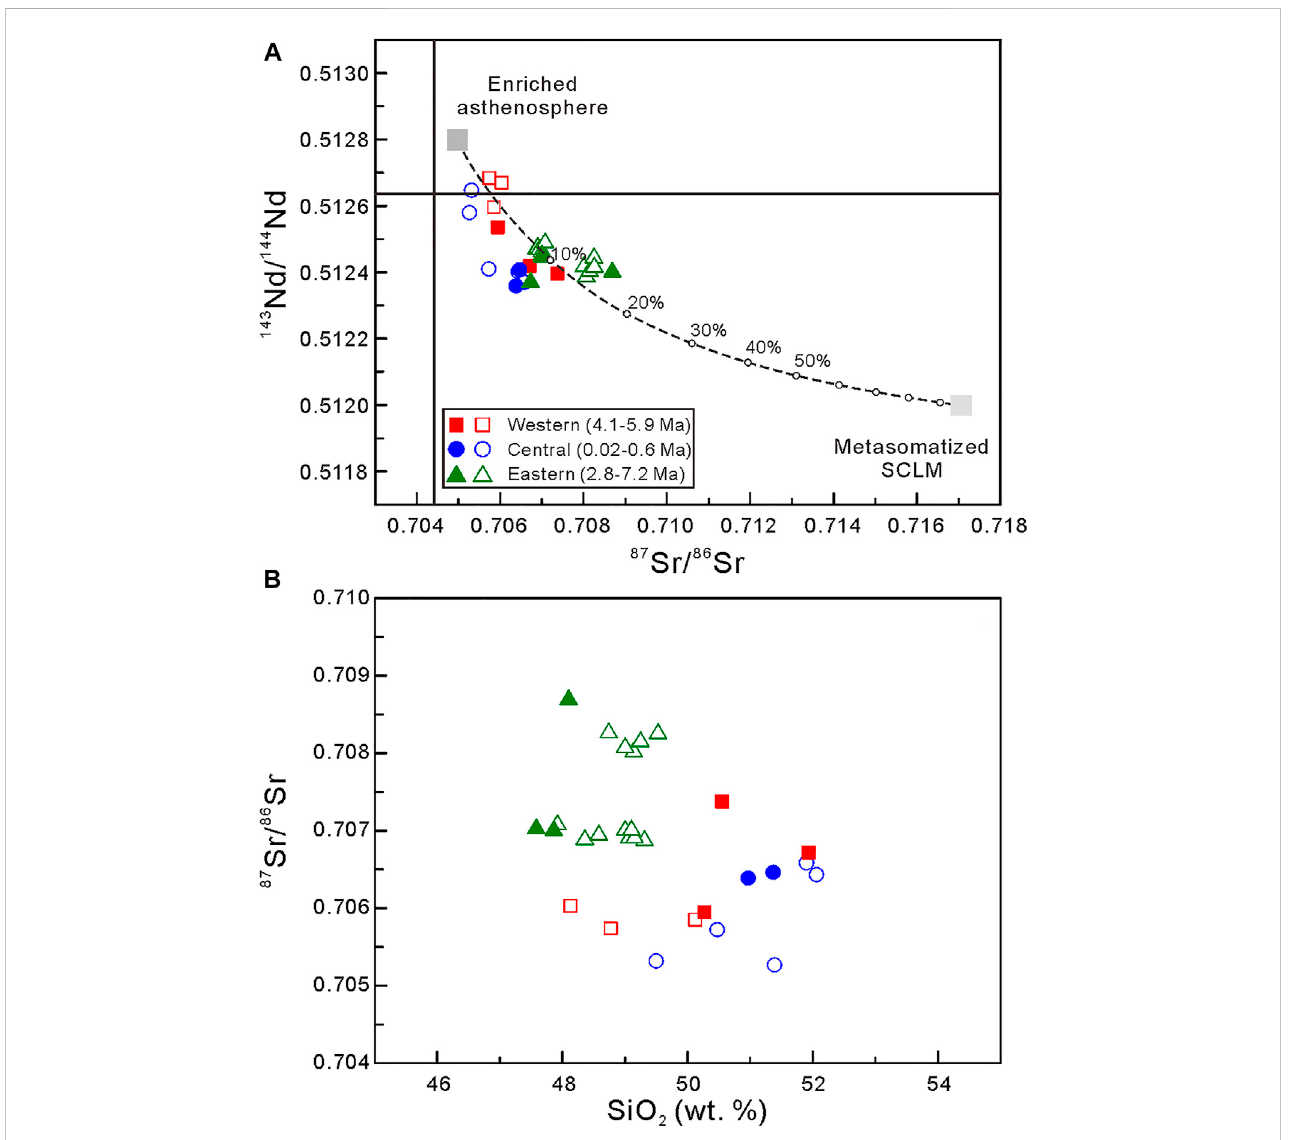
FIGURE 6 (A) Diagram of 143 Nd/ 144 Nd versus 87 Sr/ 86 Sr; (B) diagram of 87 Sr/ 86 Sr versus SiO 2 for the Tengchong basalts. The isotopic compositions of two geochemical endmembers in plot (A) are based on Miller et al. (1999) and Cheng et al. (2020). In plot (A) , the dotted curve denotes two-component mixing, and the ratios indicate the percentage of contribution from metasomatized SCLM. The fi lled symbols denote data from this study, and the open symbols are from the